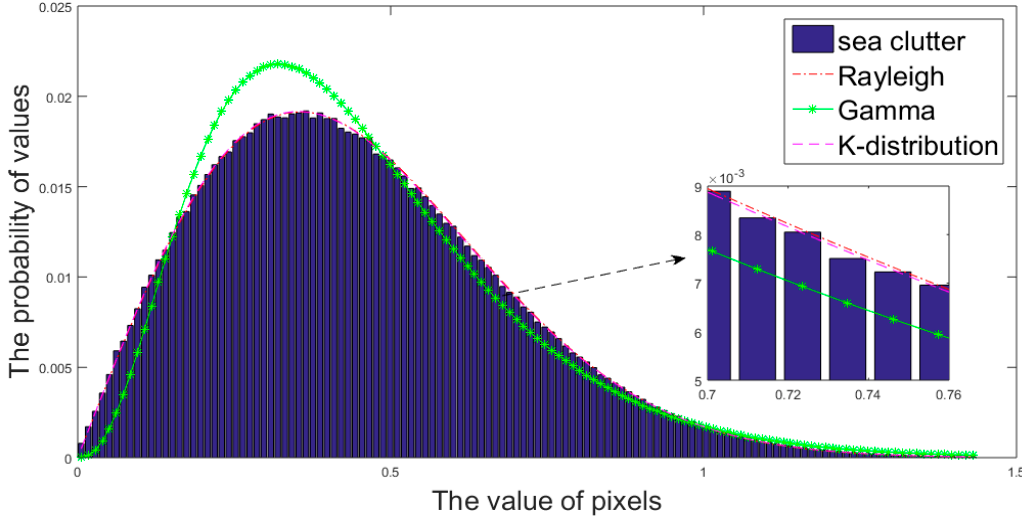
Figure 5. The histogram of sea clutter and three corresponding distribution curves.